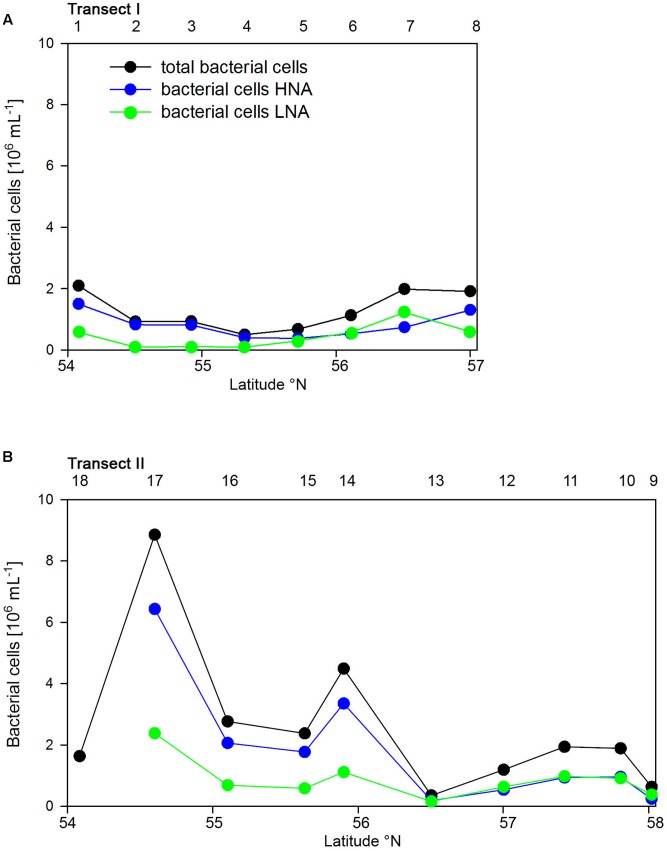
Numbers of total, high (HNA) and low nucleic acids (LNA) containing bacterial cell of Transects I (A) and II (B) during early summer in the North Sea between 54° and 58°N. The numbers above the panels indicate station numbers.